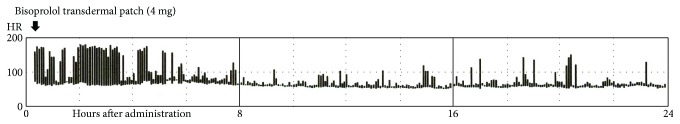
Patient (case 3) heart rate (HR) trends during treatment.